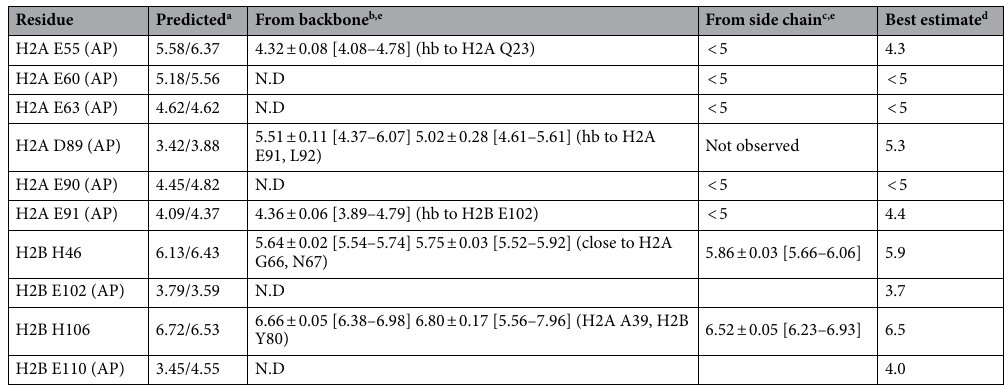
Table 1. pKa for all titratable groups in the H2A-H2B dimer. a Predicted value based on dimer/nucleosome structure. b Best estimate of side chain pKa based on backbone NH chemical shift derived pKa app of neighbouring residues (indicated in brackets, hb = hydrogen bond, N.D. = not determined). c Best estimate of side chain pKa based on 13 CO chemical shift pH titration. d Side chain pKa value when available, otherwise best estimate from NH pKa app when available, otherwise structure predicted pKa. e Experimental values are given as best-fit value with Monte Carlo based errors, the 95% confidence interval based on F-statistic is given between square brackets.